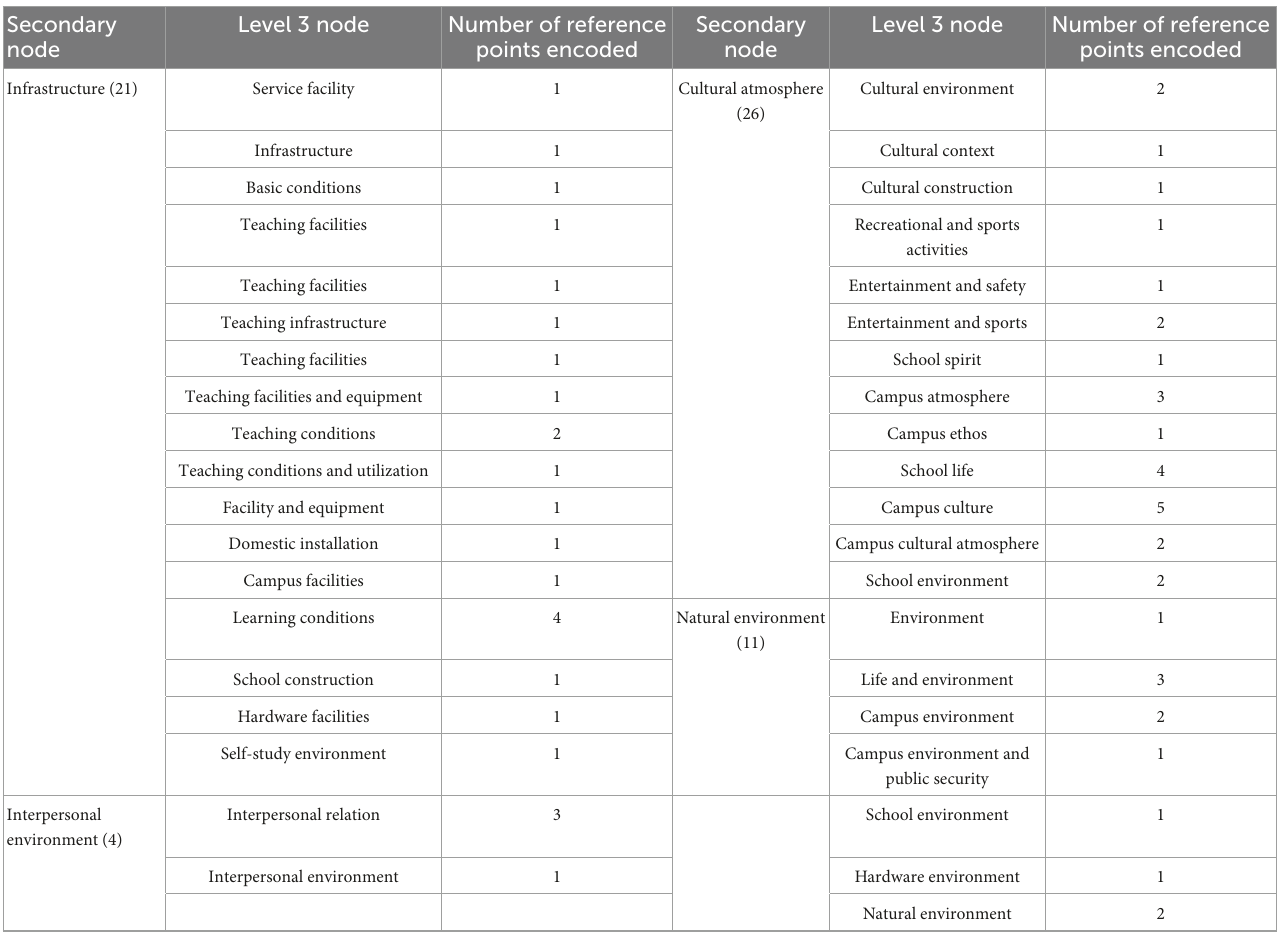
TABLE 3 Nodes and coding reference points in school